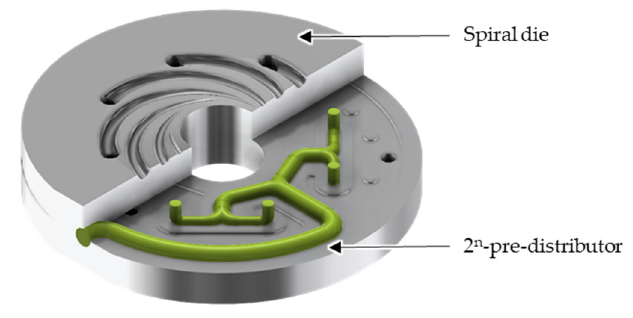
Figure 1. The 2 n -pre-distributor in combination with a spiral die as main distributor in a blown film process.